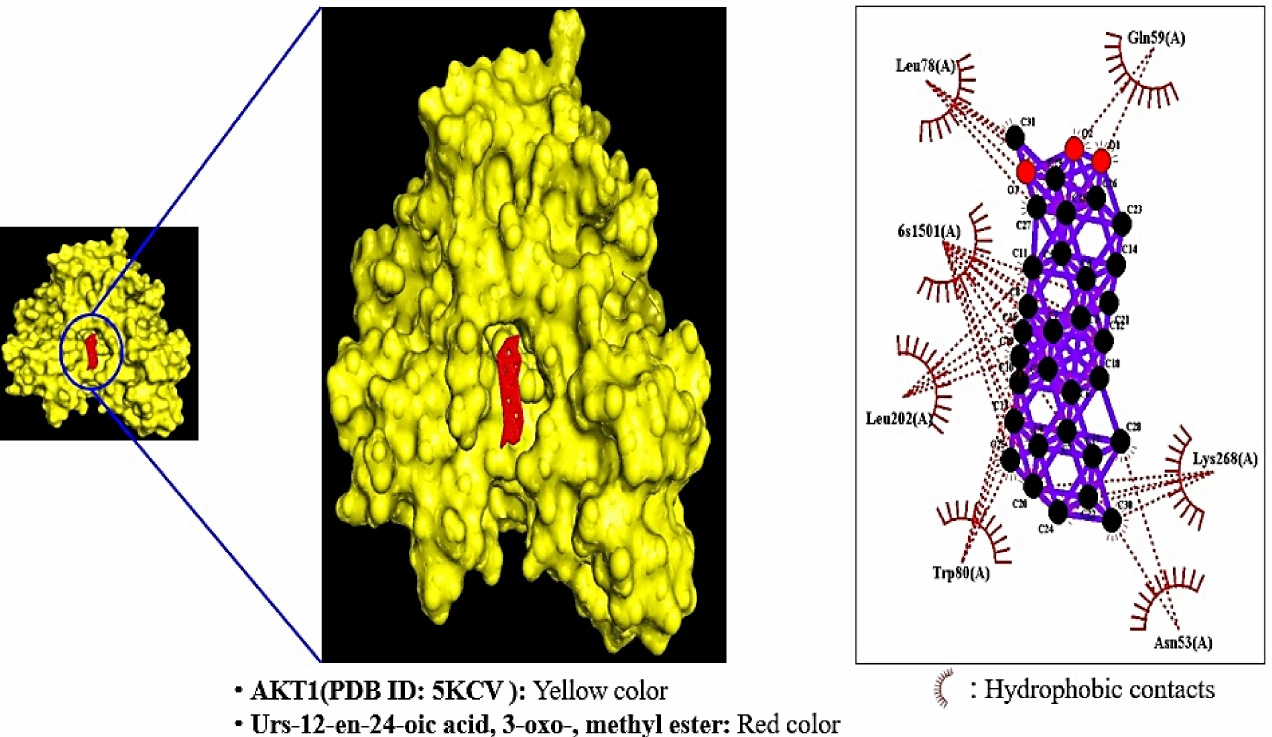
Figure 7. MDT of Urs-12-en-24-oic acid, methyl ester on Akt1 (PDB ID: